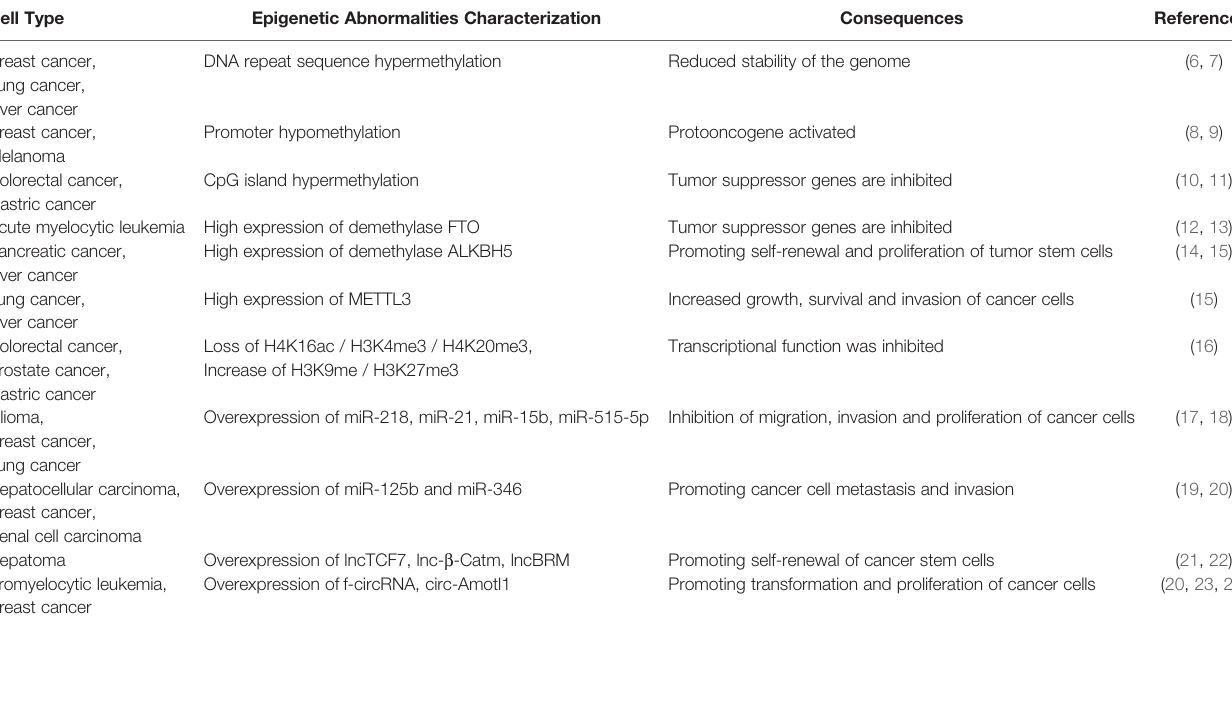
TABLE 1 | Associations between epigenetic disorders and